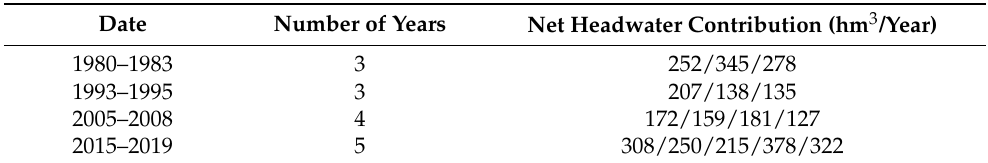
Table 4. Annual net headwater contributions for the droughts detected in the period 1980/81-2019/20. Source: own elaboration based on [34,48].